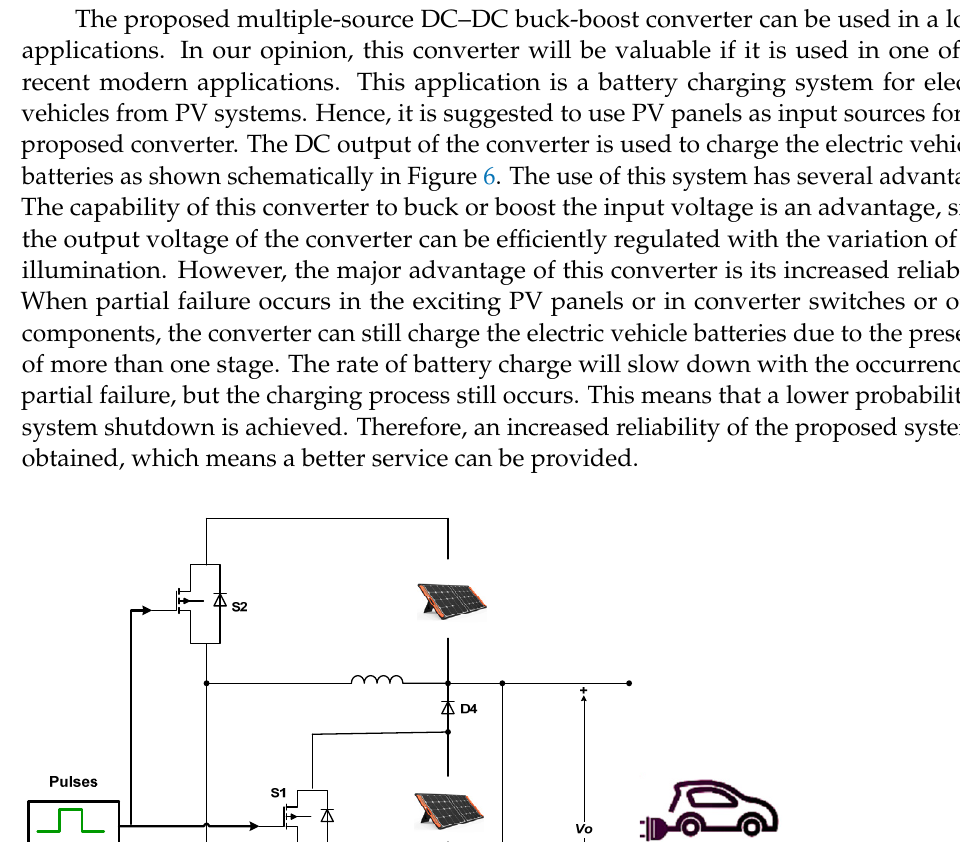
Figure 5. Schematic diagram showing the inductor current and voltage across it with pulse varia- tion considering dis-continuous current mode.